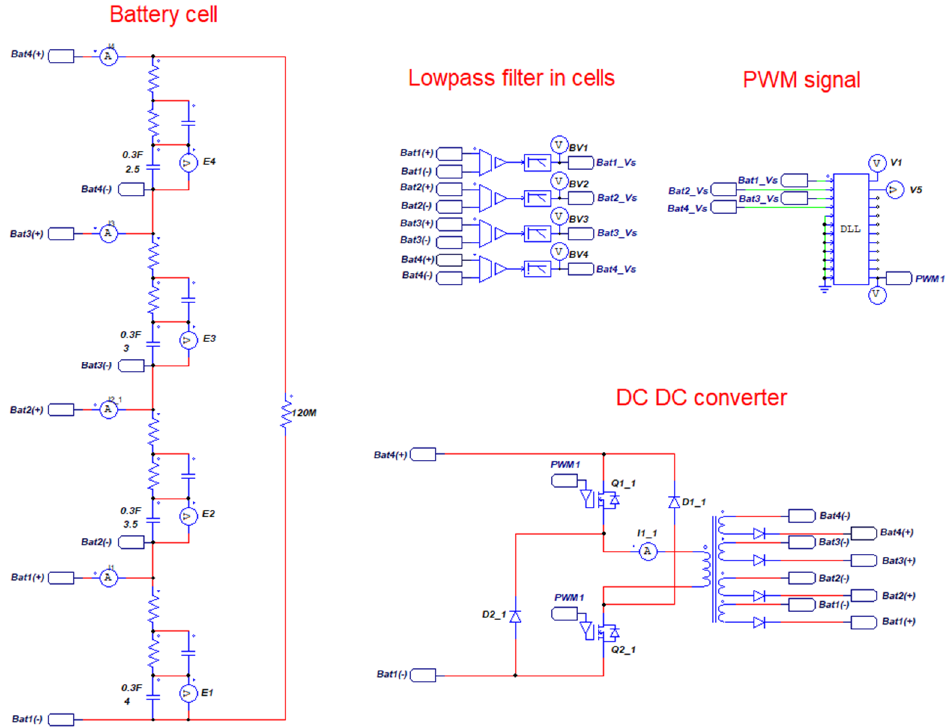
Figure 10. Circuit for simulation and verification.